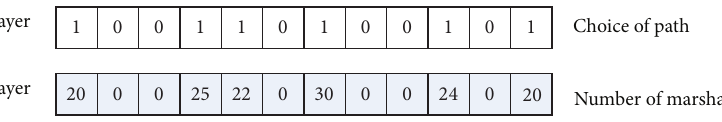
Figure 2: Illustration of chromosome coding